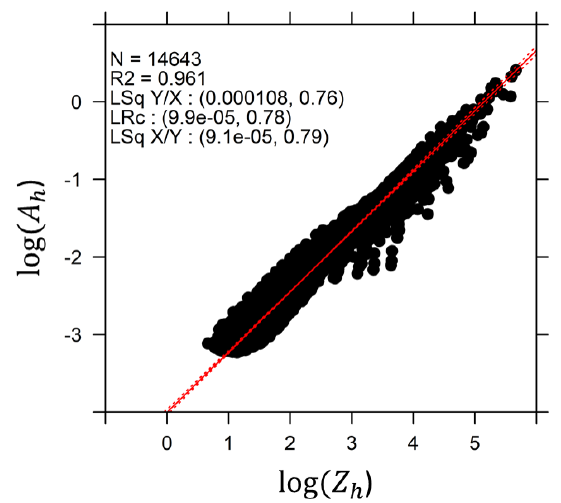
Figure 3. Results of the fitting of DSD-derived power law models for the horizontal specific attenuation A h (dBkm − 1 ) as a function of the horizontal reflectivity Z h (mm 6 m − 3 ), using a classical loga- rithmic of base 10 transformation of the two variables. In the insert, the number of points N , the square of the correlation coefficient ( R 2 ) of the logarithmic regression, the prefactors and exponents of the resulting least square regressions of the variable in ordinate ver- sus the variable in abscissa (Lsq Y/X ) and vice versa (Lsq X/Y ), as well as the least rectangle regression (LRc), which considers the two variables on an equal footing, are